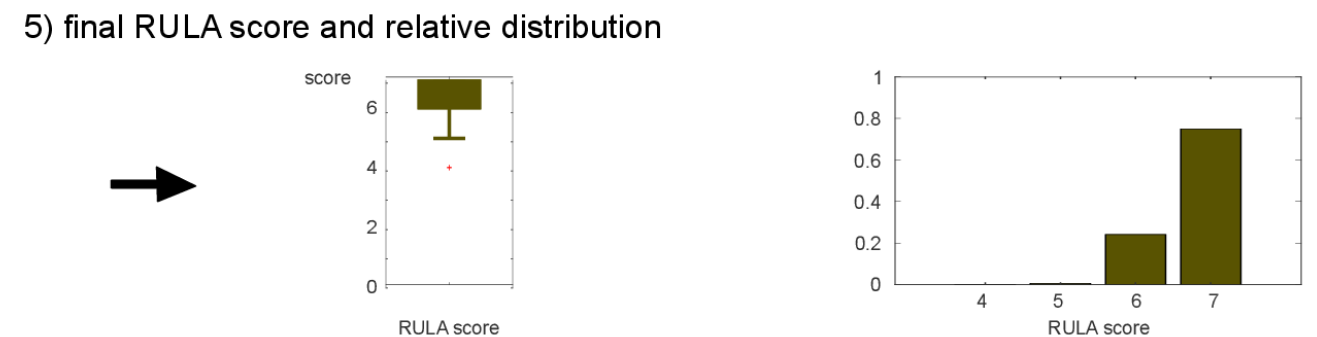
Figure 3. Five main processing stages to calculate the RULA score for time-dependent signals. The displayed processing stages highlight the key features of the workflow (only a small subset of variables is displayed). Raw data 1: the limits for the specific joints are applied for all time points, leading to a downscaling of the resolution. For some steps, more than one joint is used, and the final score for this step is calculated by adding the individual scores at every time point 2. The score for the arm is calculated by a look up table for all time points 3. A similar procedure is used to combine the final score for the arm (step 8) and the final score for the trunk (step 15) for every time point 4. The RULA score is calculated based on the median value of the whole time series 5. Table 1. RULA modifications. This table sums up the modifications to several original RULA steps that were applied in order to quantify and automate qualified